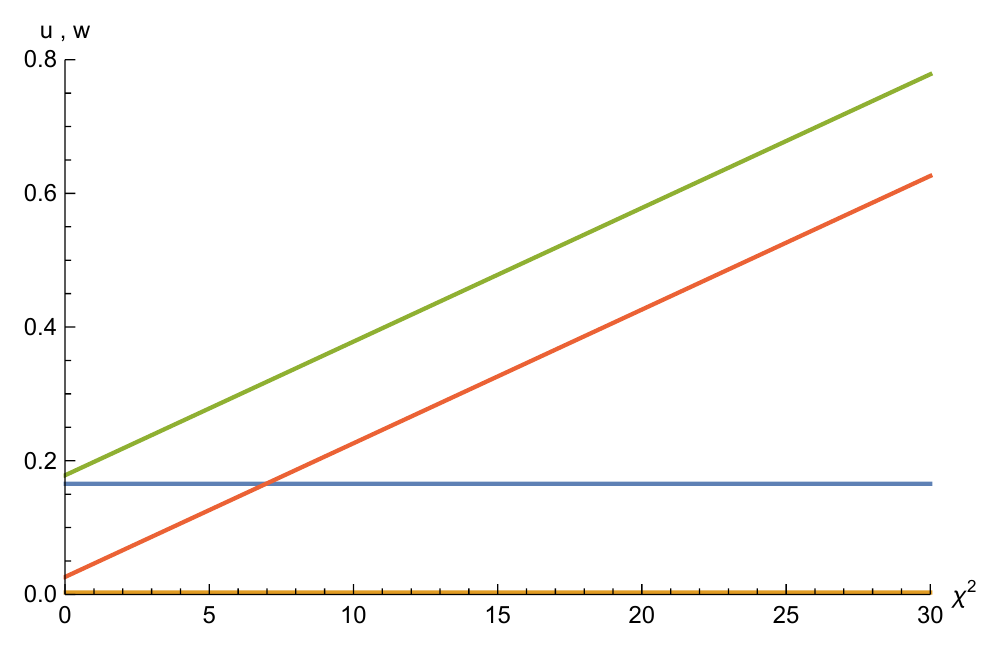
Figure 2. Crossover functions. We plot u = U / k 4 (horizontal lines) and w = F / ( 2 k 2 ) as functions of χ 2 / M 2 . Parameters u 0 and w 0 are given by Equations (21) and (23) with ξ = 0.01. They depend on the number of gauge bosons N V , fermions N F , and scalars N S . The upper curves use N V = 45, N F = 48, N S = 326, as appropriate for SO(10) grand unification, and the lower curves are for N V = N F = N S =